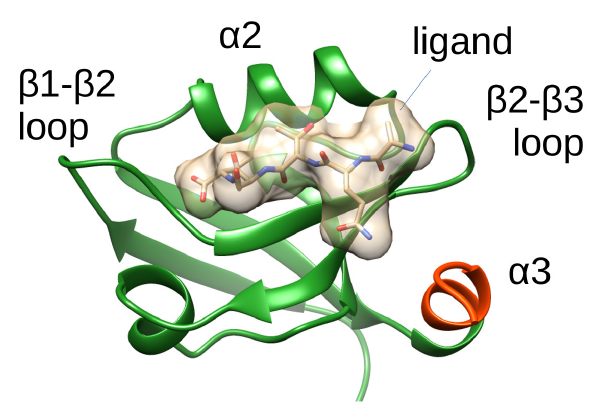
Figure 1. Ribbon representation of PSD-95 PDZ3 (residues 303-402) based on PDB structure 1BE9. The ligand, the α 2 helix and the loops flanking the ligand binding site are labeled. The 7 residues of the additional α 3 helix truncated in [21] are shown in red. The structure was drawn using UCSF